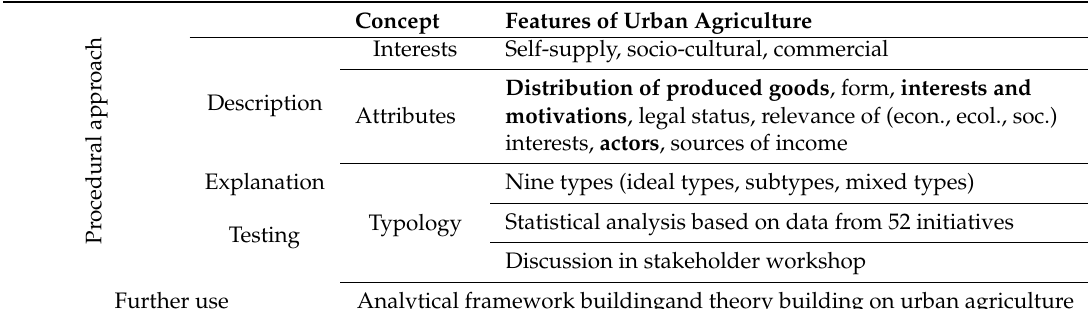
Table 2. Procedural Approach Applied for the Typology Development, Structured Along Research Steps in Framework and Theory